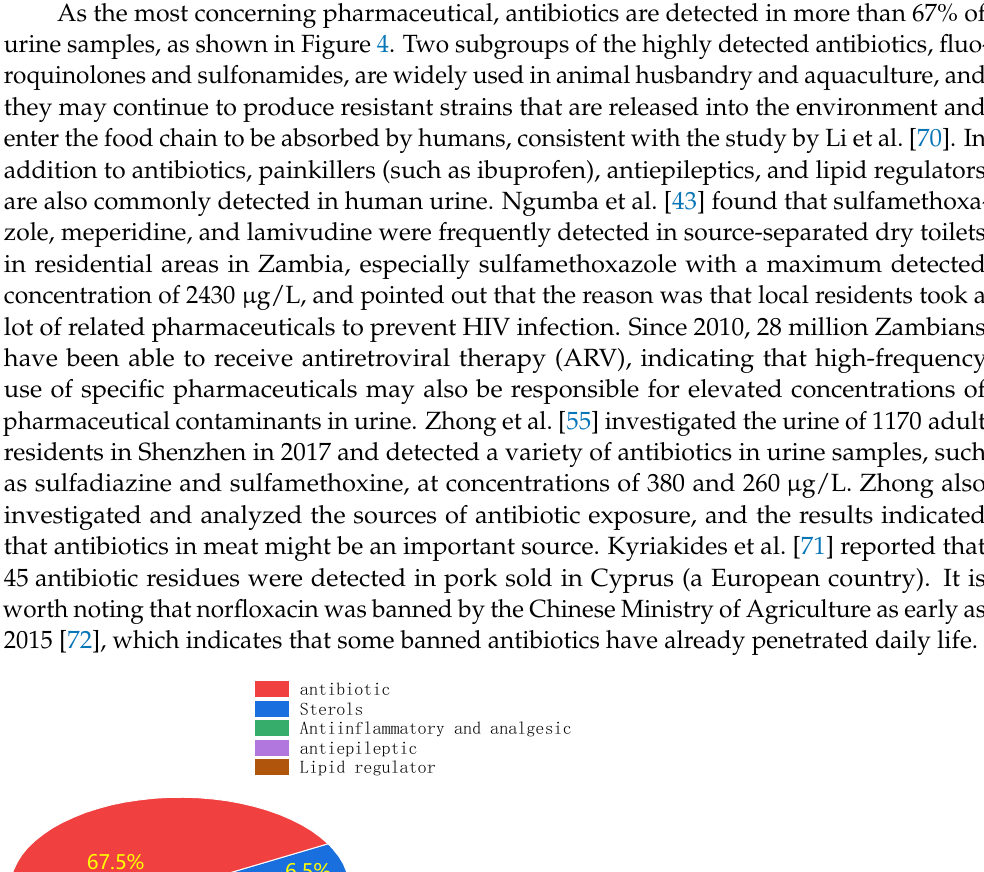
Figure 4. The main categories of detected pharmaceutical contaminants in urine (data from [43,47– 69]).